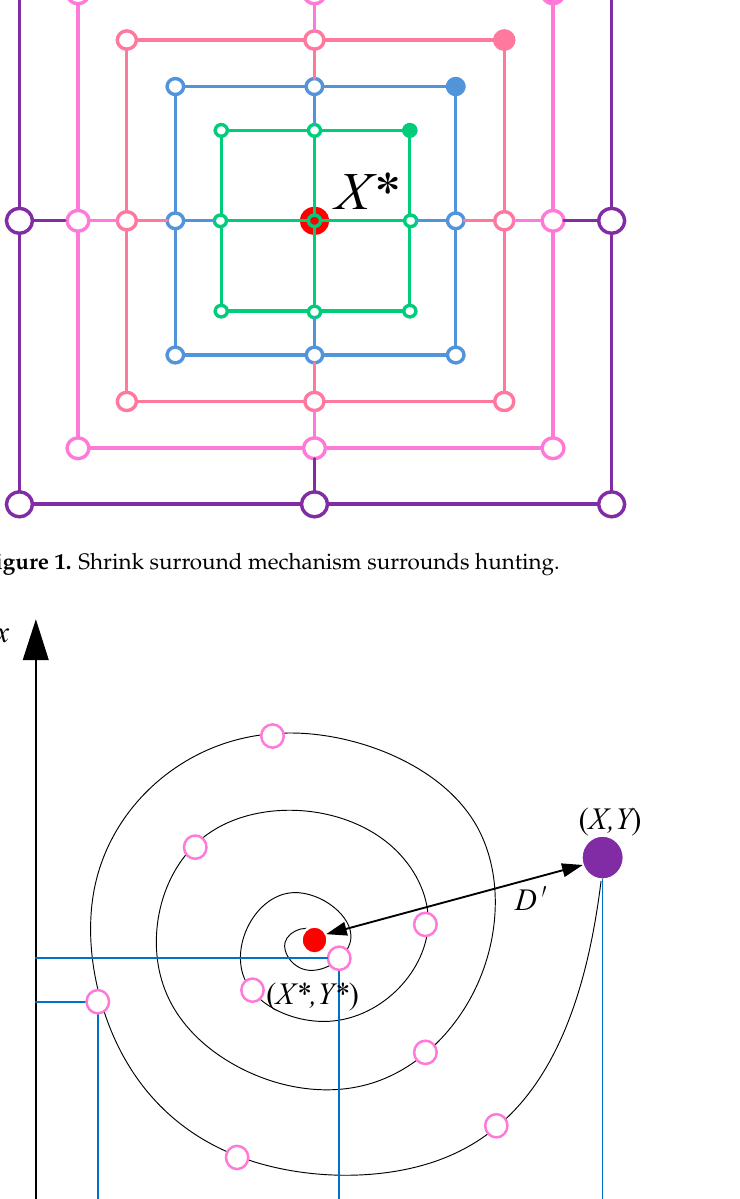
Figure 1. Shrink surround mechanism surrounds hunting.